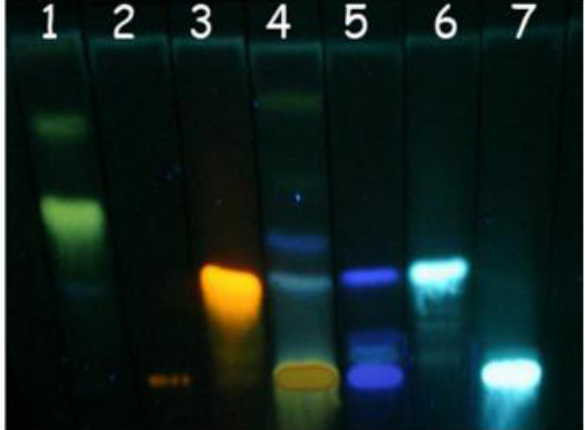
Figure 1. Thin Layer Chromatography. D. alata hydroalcoholic extract and phytochemical standards. Solvent system - acetone: chloroform: formic acid (10:75:8 v/v). Developer: NP/PEG. 1. Apigenin, 2. Rutin, 3. Quercetin, 4. D. alata hydroalcoholic extract, 5. Tannic acid, 6. Caffeic acid, and 7. Chlorogenic acid. The chromatographic profile exhibits yellow –orange (flavonoids) and blue colored (phenolic acids) spots characteristic of phenolic